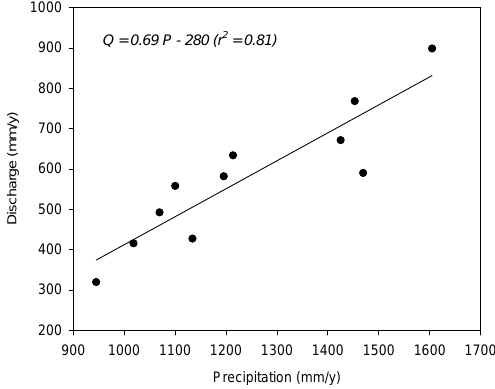
Fig. 2. Long-term precipitation and discharge relationship in the Han